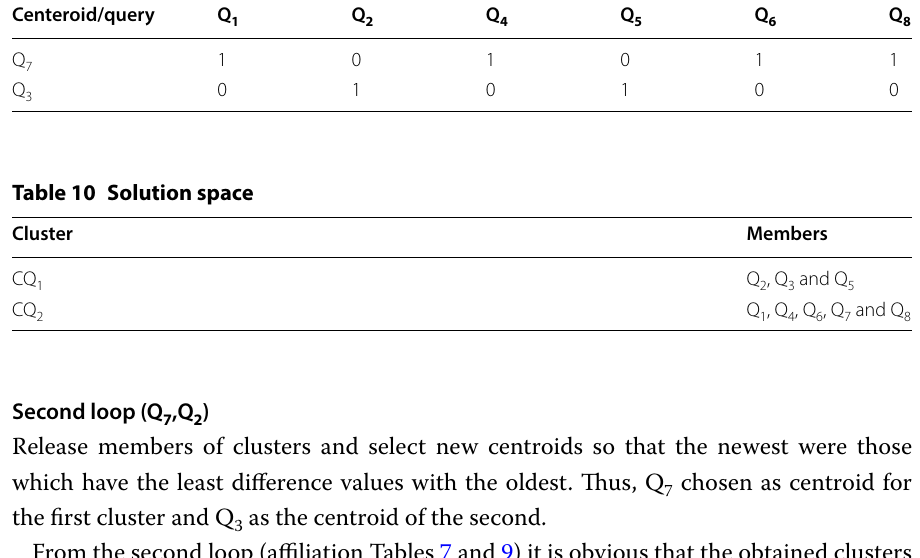
Table 9 Member’s affiliation (second loop) Centeroid/query